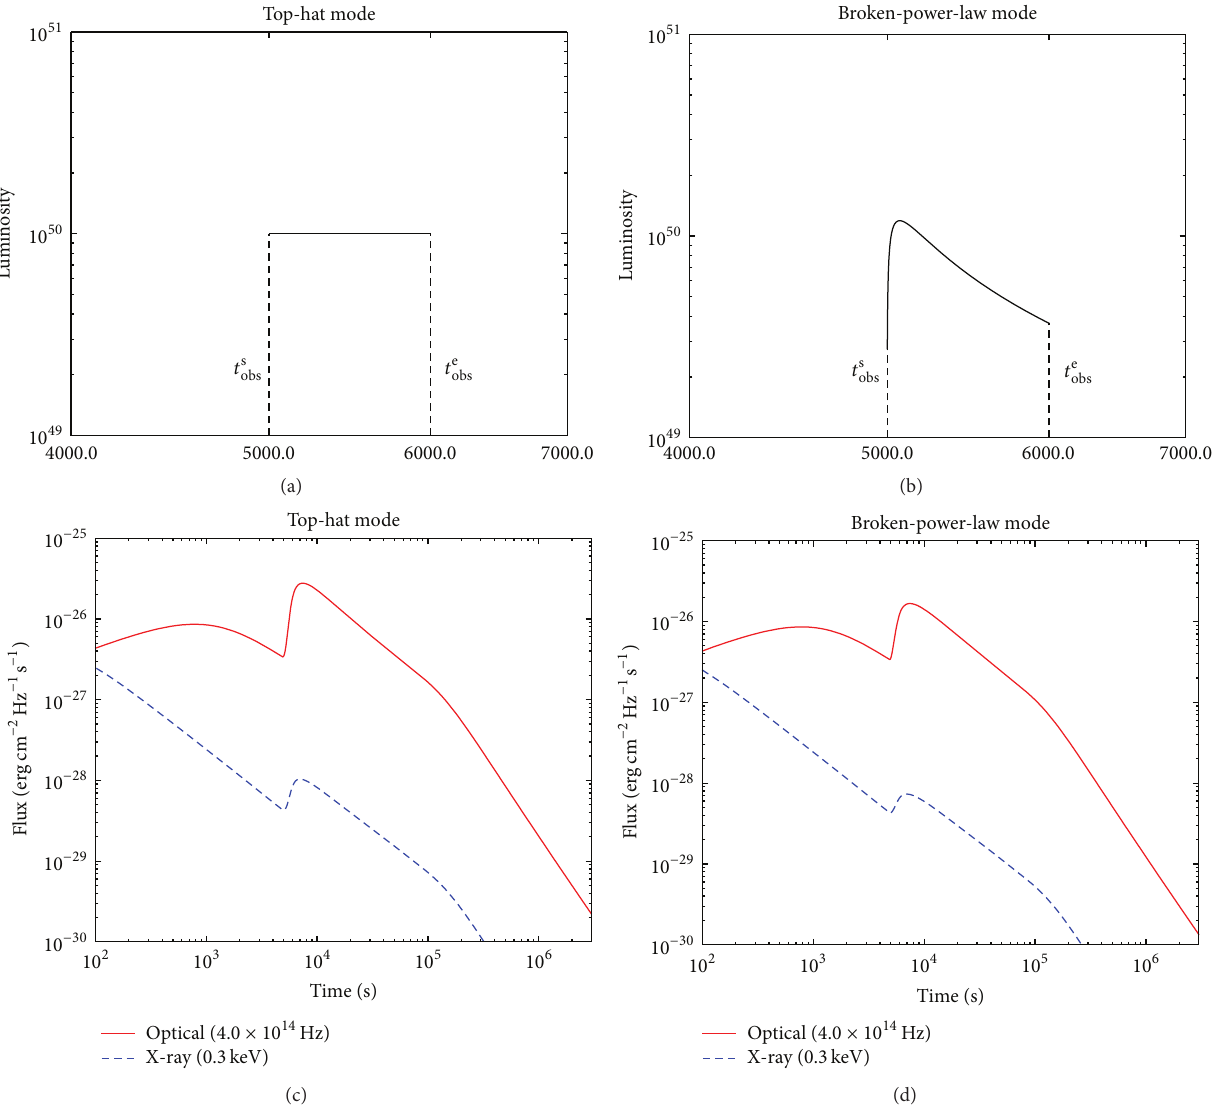
Figure 3: (a) Schematic illustration of the top-hat injection mode, in which 𝐿 0 = 10 50 ergs −1 (isotropic), 𝑡 s obs = 5000 s, and 𝑡 e obs = 6000 s. (b) Schematic illustration of the broken-power-law (see (4)) injection mode, in which 𝐿 p = 10 50 erg s −1 (isotropic), 𝑡 s obs = 5000 s, 𝑡 p obs = 5200 s, = 6000 s, 𝛼 = 0.5 , 𝛼 = −1.5 , and s = 0.5 . (c) and (d) show the corresponding afterglows of the two modes correspondingly. In the 𝑡 e 𝑟 𝑑 obs calculations, a redshift of 𝑧 = 1 is assumed. Similar plots can be found at